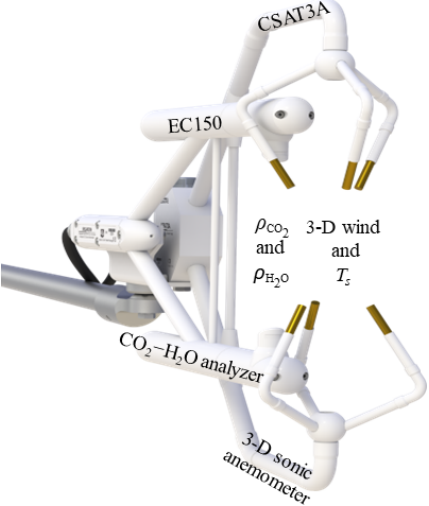
Figure 1. Integration of an EC150 infrared CO 2 –H 2 O analyzer for CO 2 density ( ρ CO ) and H 2 O density ( ρ H ) with a CSAT3A sonic 2 2 O anemometer for three-dimensional (3-D) wind velocities and sonic temperature ( T s ) in an open-path eddy-covariance flux system (Im- age credit: Campbell Scientific Inc., UT,